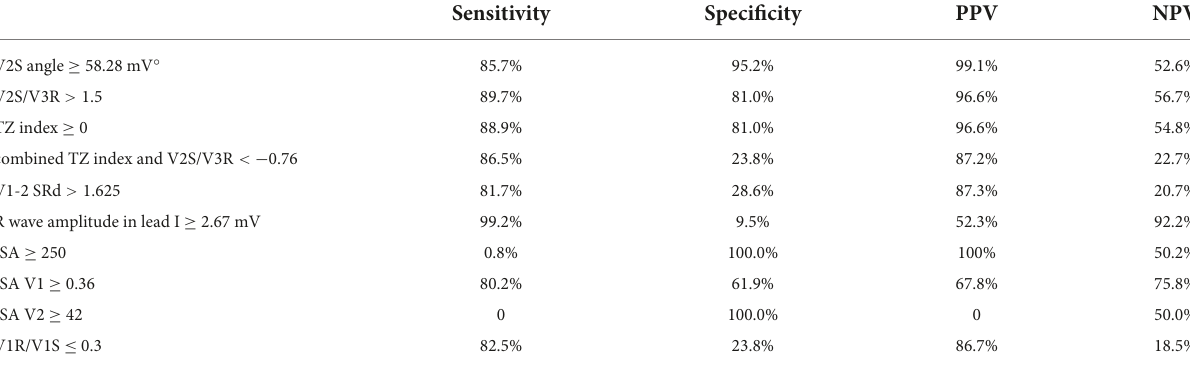
TABLE 3 Diagnostic indexes of ECG criteria for predicting RVOT